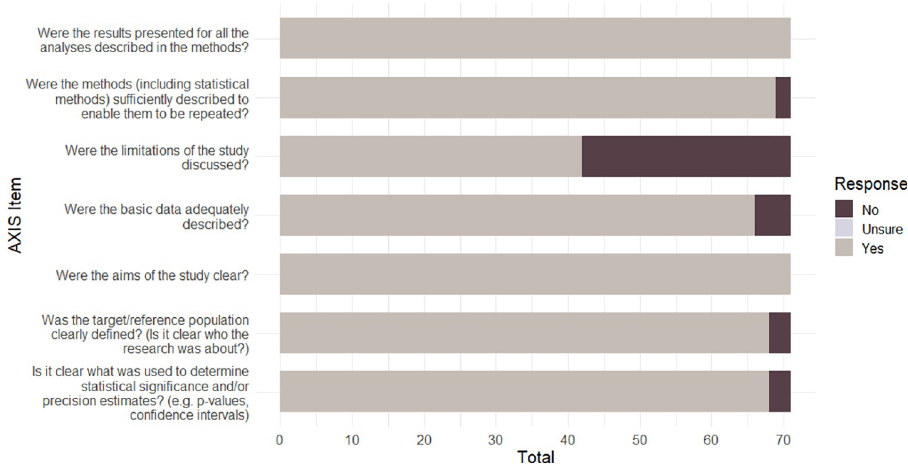
Fig 2. AXIS reporting quality summary for the 71 papers included in the